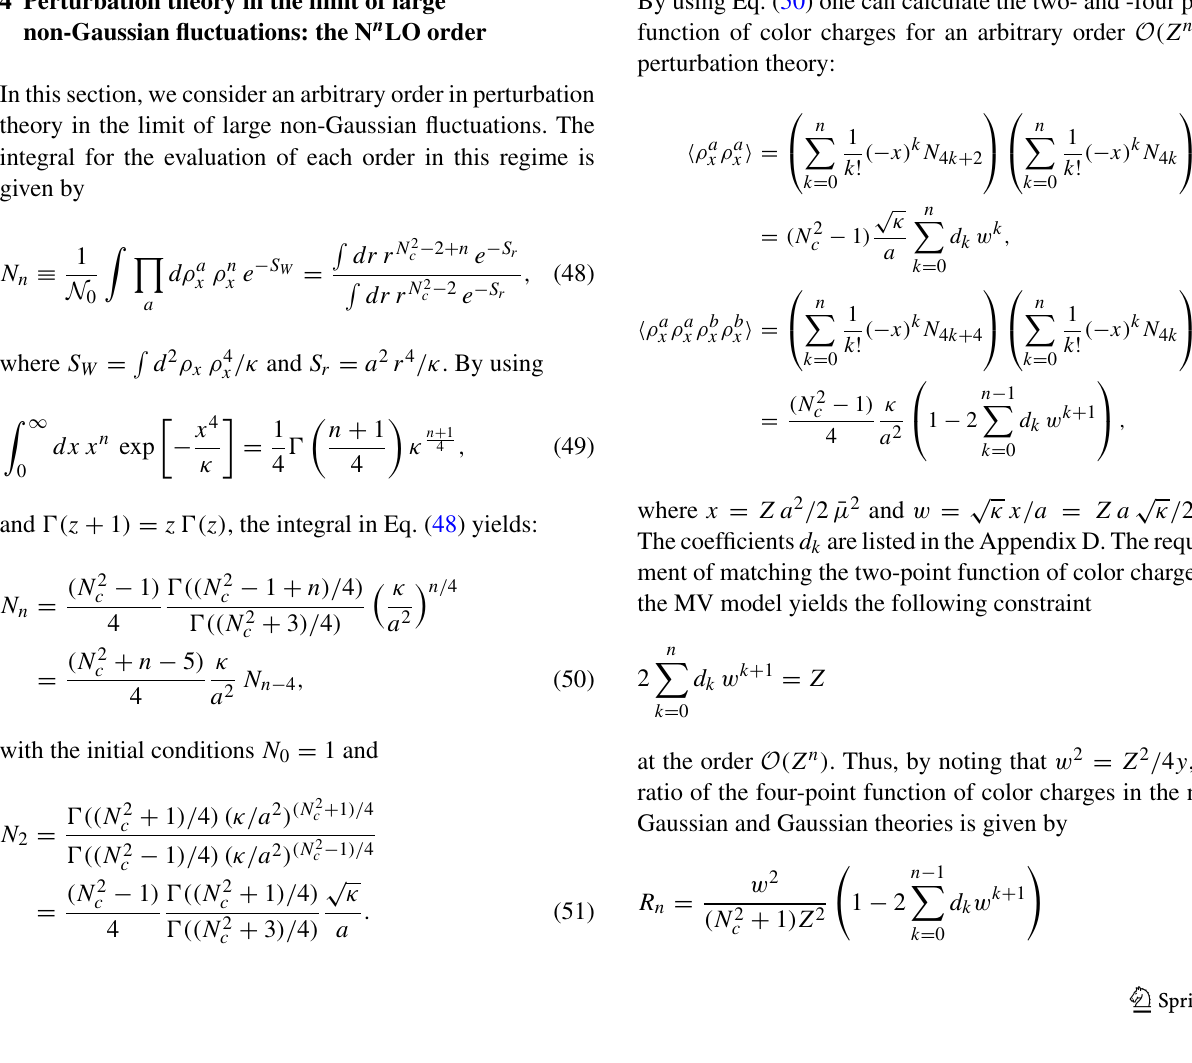
Fig. 4 The difference between the exact solution and the N n LO calculations for SU(3) at Z = 0 . 84 (left panel) and Z = 0 . 78 (right